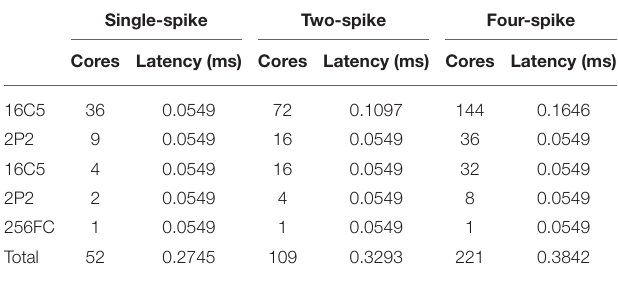
TABLE 10 | Chip utilization and latency for VGG-Net.